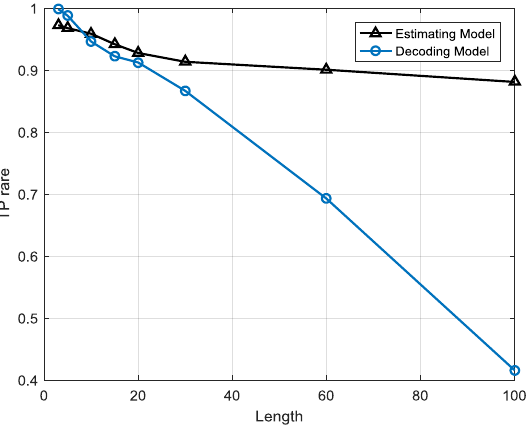
Figure 19. Comparison between the estimation-based and decoding-based models on TP rate.